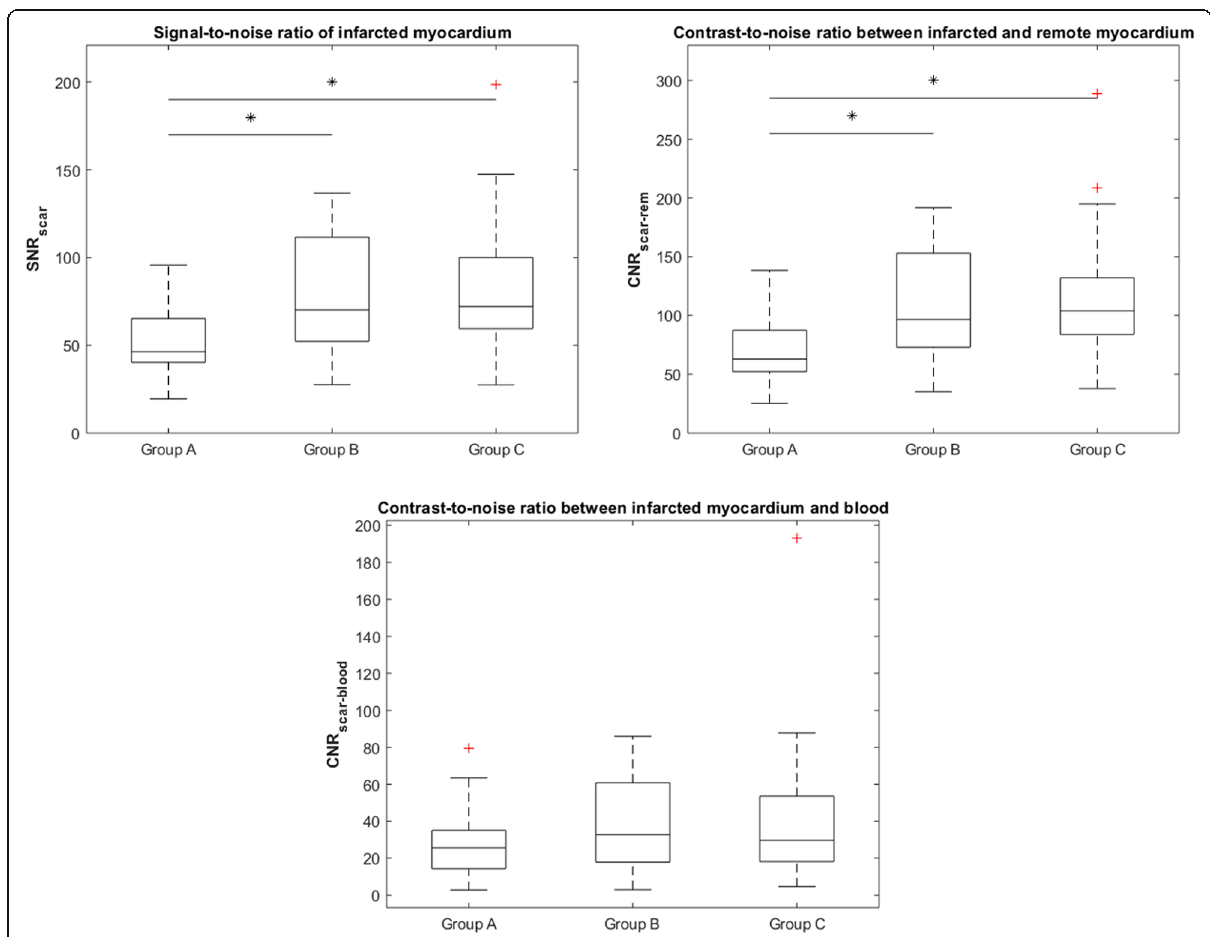
Fig. 4 Box plots of signal-to-noise ratio of the scarred myocardium (SNR scar ), contrast-to-noise ratio between infarcted and remote myocardium (CNR scar-rem ), and contrast-to-noise ratio between infarcted myocardium and blood (CNR scar-blood ) in the three groups being administered 0.10 (group A), 0.15 (group B), and 0.20 (group C) mmol/kg of gadobutrol. Significant differences between groups are indicated with an asterisk (*), and red crosses (+) indicate outliers. In particular, SNR scar was lower in group A (46.4 IQR 40.3 – 65.1) than in both group B (70.1 IQR 52.2 – 111.5, p = 0.013) and group C (72.1 IQR 59.4 – 100.0, p = 0.002), and CNR scar-rem was lower in group A (62.9 IQR 52.2 – 87.4) than in both group B (96.5 IQR 73.1 – 152.8, p = 0.008) and group C (103.9 IQR 83.9 – 132.0, p = 0.001). There